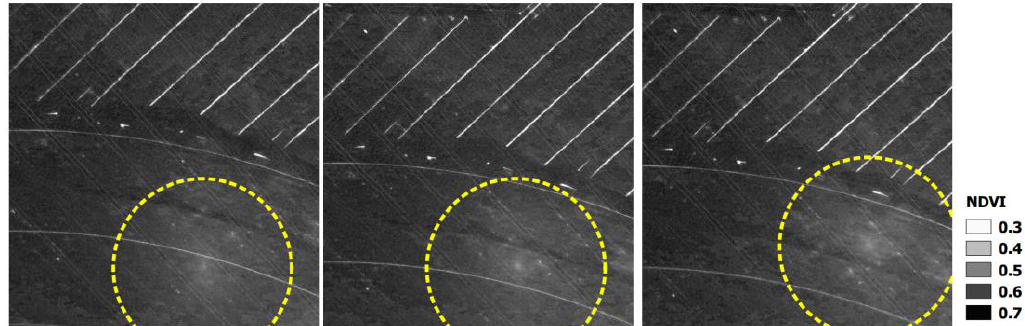
Figure 11. Normalized digital vegetation index (NDVI) images and the corresponding NDVI values in the hotspot areas detected (yellow circle).